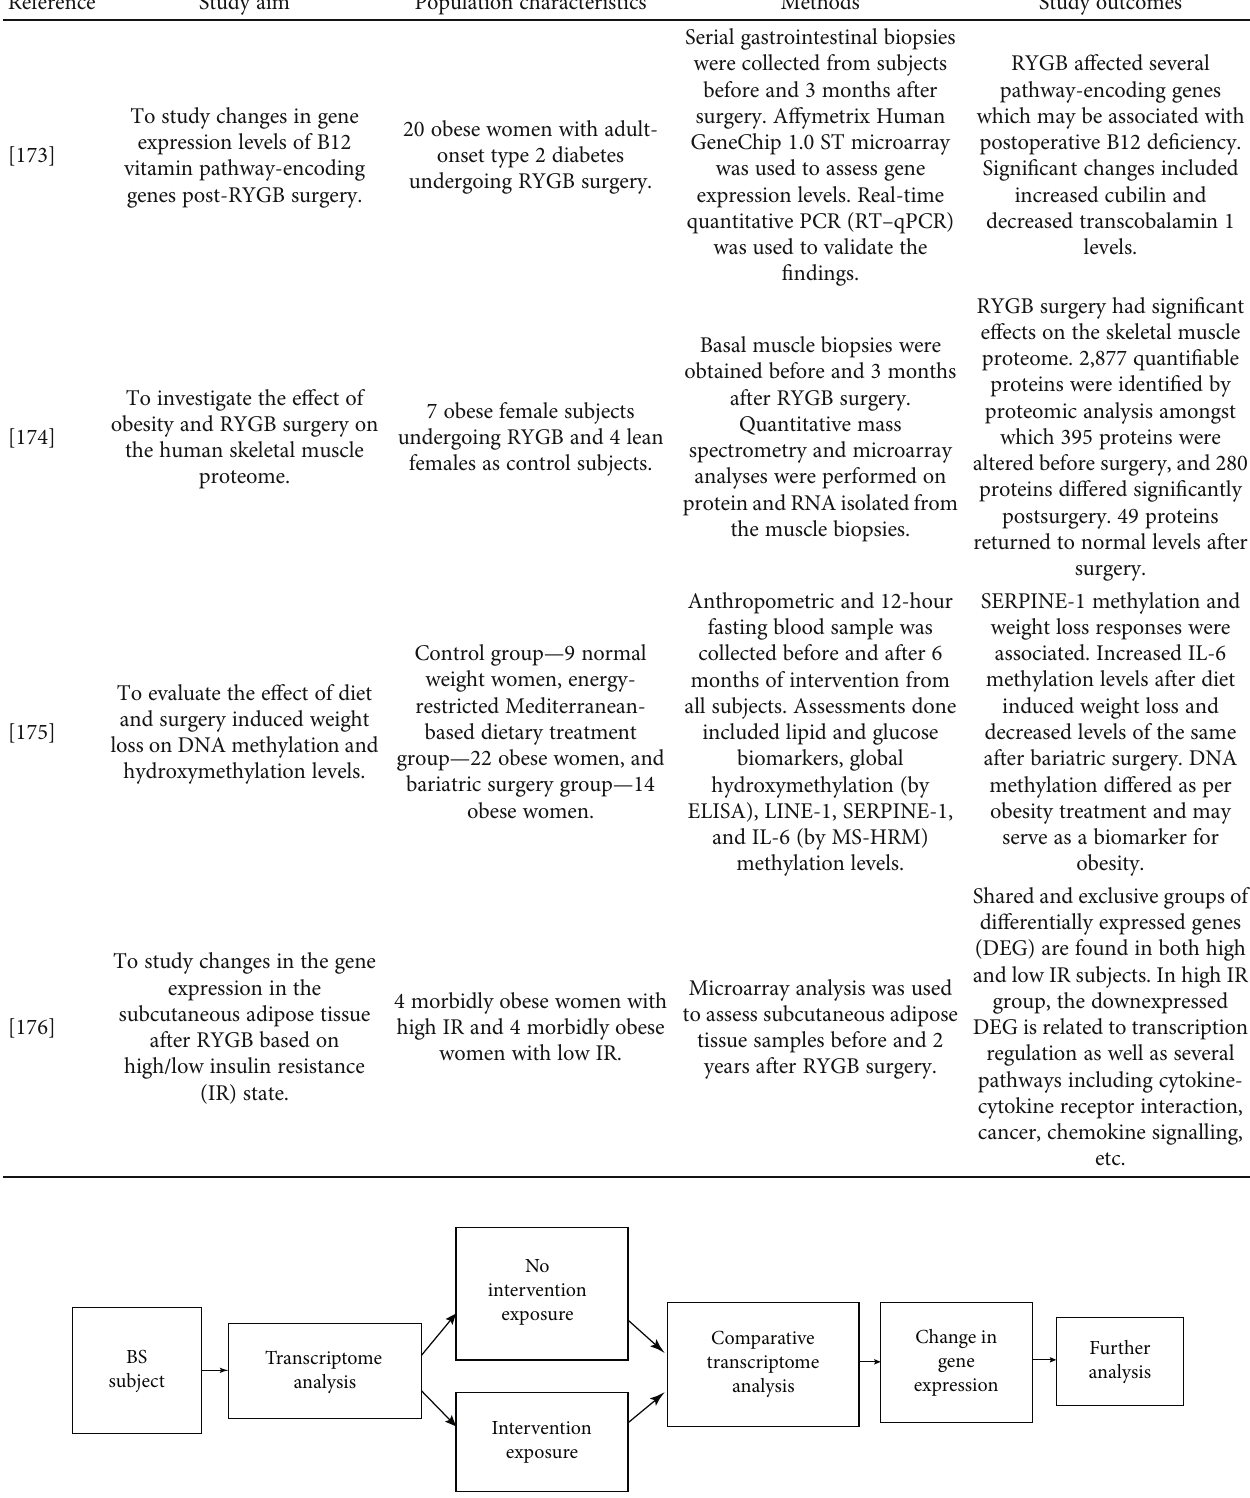
Figure 1: Schematic representation of an experimental format for nutritional studies using transcriptomic